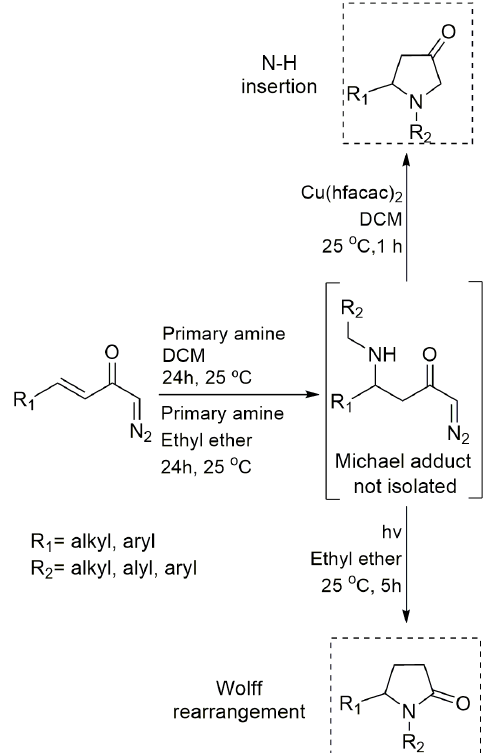
Figure 56 - One pot synthesis of 2 and 3-pyrrolidines from α,β-unsaturated